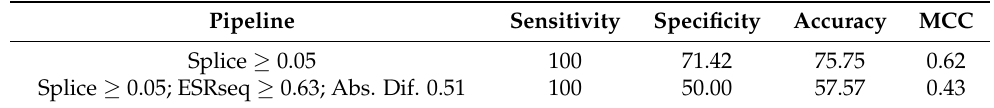
Table 4. Performance pipeline (experimental variants dataset) with 33 variants: 5 splicing altering and 28